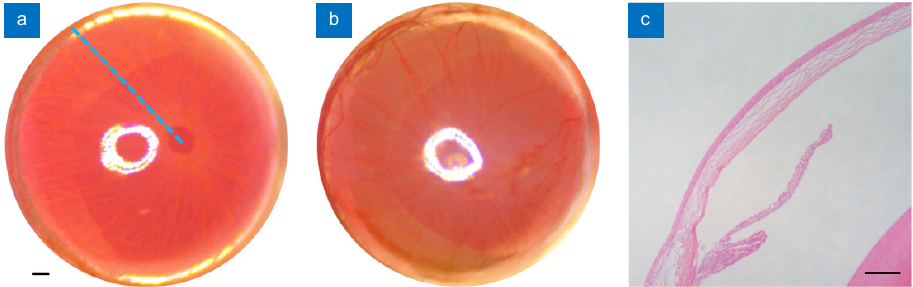
Fig. 3 | ( a−b ) The optical microscopic images of a healthy eyeball before and after burn. ( c ) The HE staining result of the eyeball after pho- toacoustic imaging. Scale bar=0.2 mm.